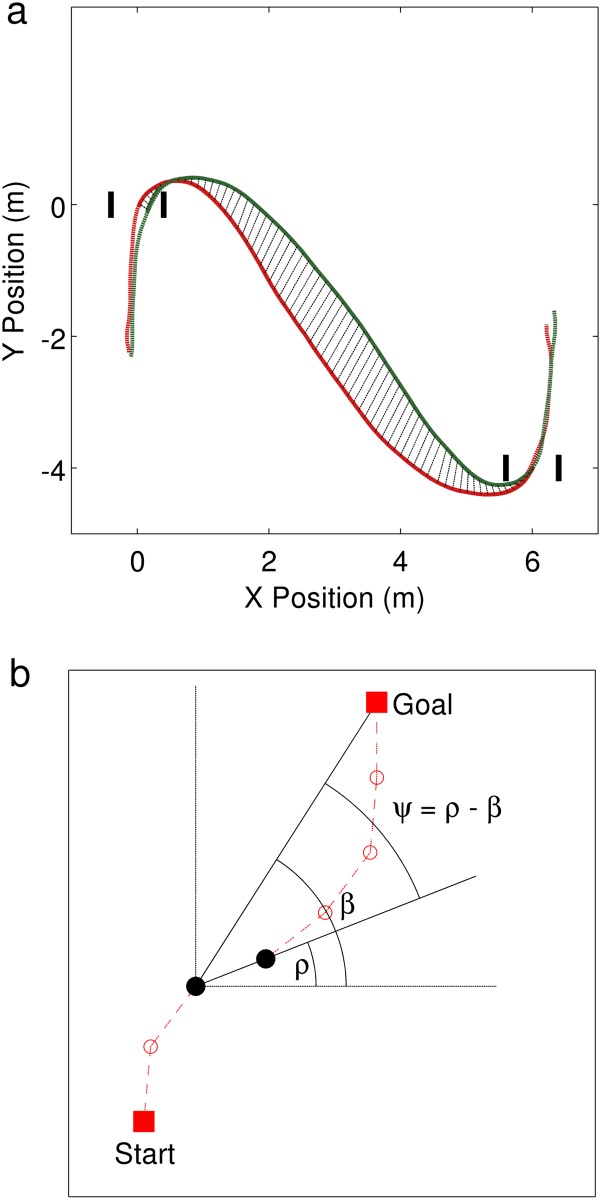
Data analysis.(A) Mean separation between forward-return paths was computed from the recorded positions. Lines between the forward-return paths indicate the time-matched epochs, τ on the forward path and 1 − τ on the return path. (B) Heading ρ, angle to target β, and bearing Ψ, were calculated from successive positions recorded along the path (dashed red line through open circles).